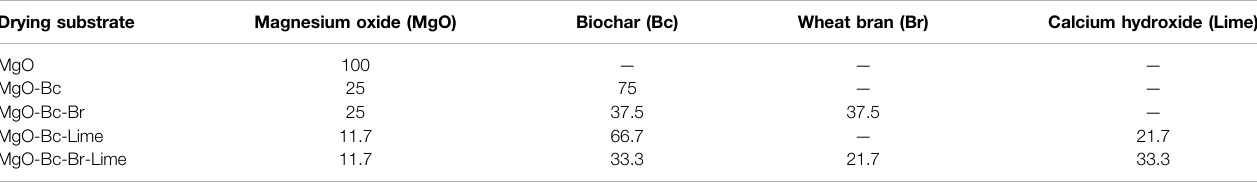
TABLE 1 | Mass composition (as % of total mass) of the fi ve drying substrates used in this study. The total mass of each substrate was 30 g. Drying